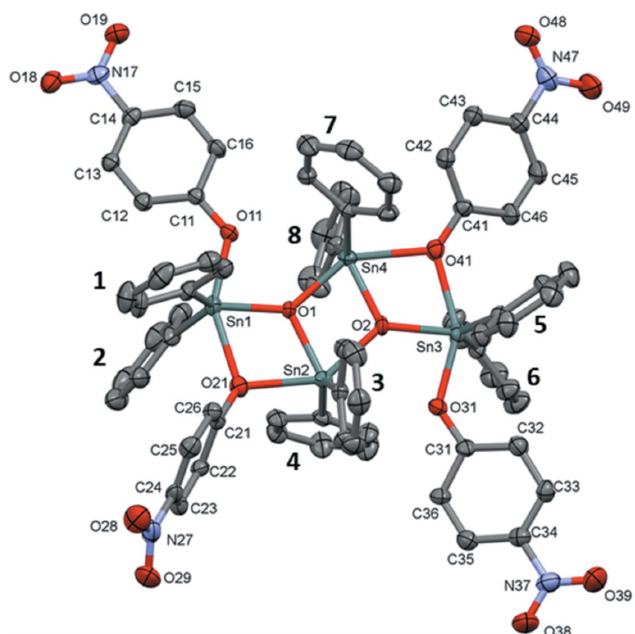
Figure 1 The molecular structure of complex A . Displacement ellipsoids are drawn at the 30% probability level. Phenyl ring 1 = C51–C56, 2 = C61–C66, 3 = C71–C76, 4 = C81–C86, 5 = C91–C96, 6 = C101–C106, 7 = C111–C116, 8 = C121–C126. For clarity, the hydrogen atoms have been omitted.